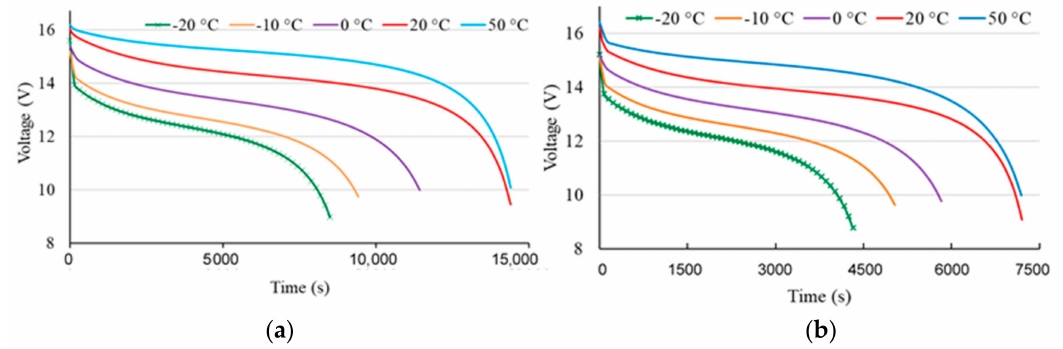
Figure 14. Simulated discharging curves of a 14.4 V 80 Ah SLI battery under five ambient temperatures: ( a ) One C-rate (20 A); ( b ) two C-rate (40